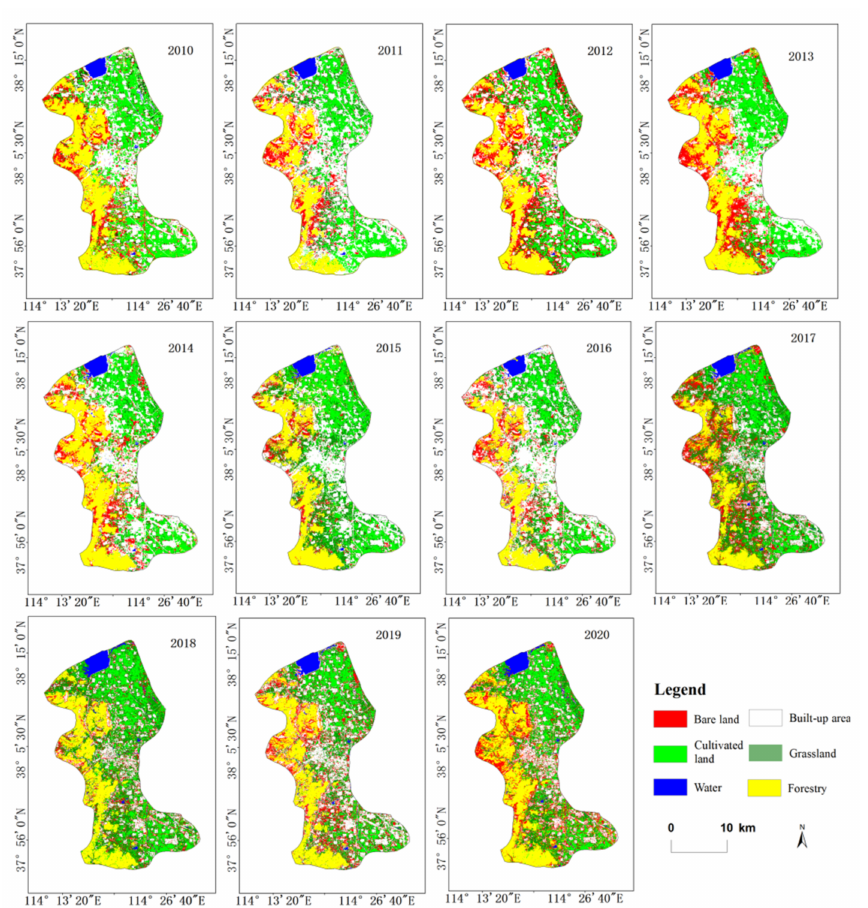
Figure 5. Land-use time-series map of Luquan from 2010 to